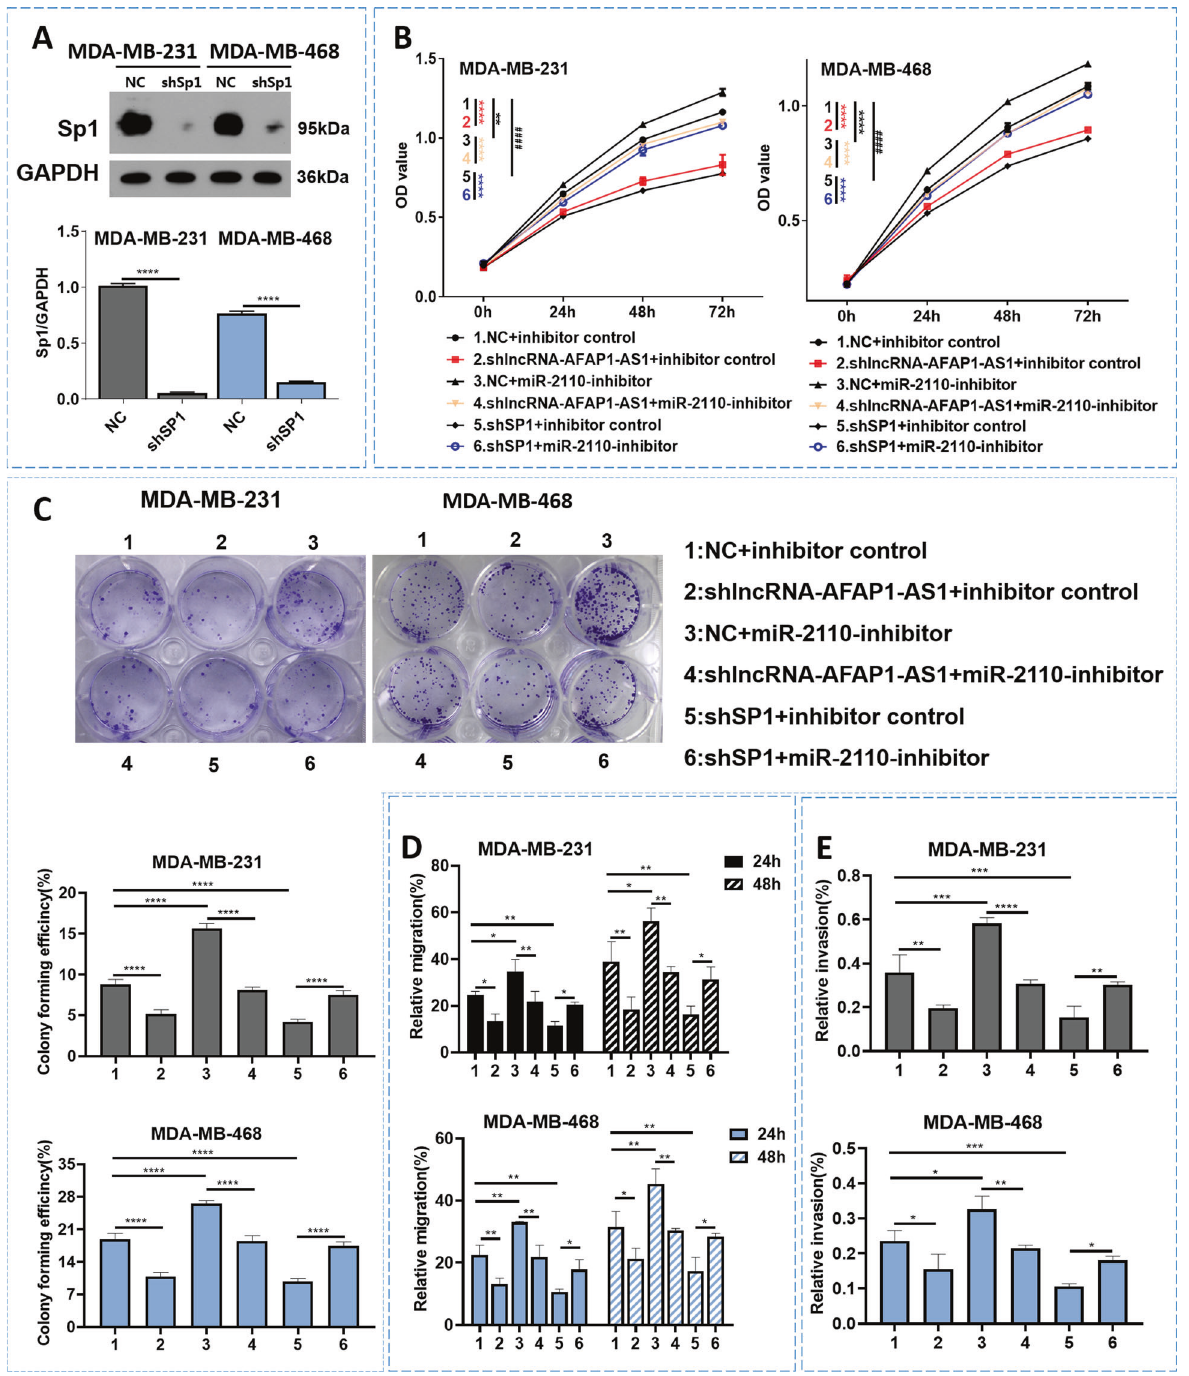
Fig. 4 AFAP1-AS1/miR-2110/ Sp1 affected the proliferation, migration, and invasion of TNBC cells. A Sp1 expression in MDA – MB-231 and MDA – MB-468 cells were examined through WB. B CCK-8 assay performed. Asterisks (*) and hash signs ( # ) represent the signi fi cant analysis between group 1 and group 2 (*), group 1 and group 3 ( * ), group 3 and group 4 (*), group 1 and group 5 ( # ), group 5 and group 6 (*), respectively. C Colony formation, D wound healing migration, and E Transwell assays performed after different treatment. Unpaired student ’ s t -test and one-way ANOVA test were used for the statistical analyses. * P < 0.05; ** P < 0.01; *** P < 0.005; **** P < 0.001; ns not signi fi